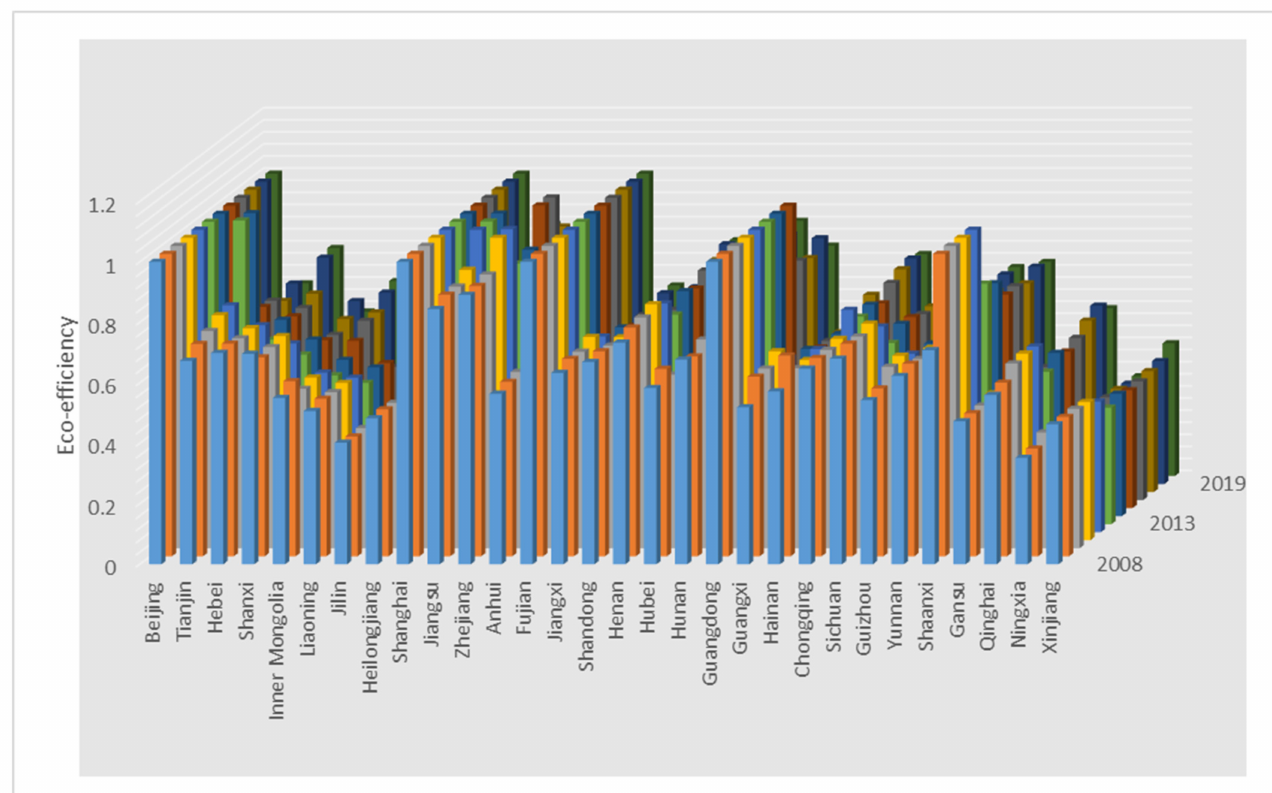
Figure 4. The values of EE for 30 provinces in China